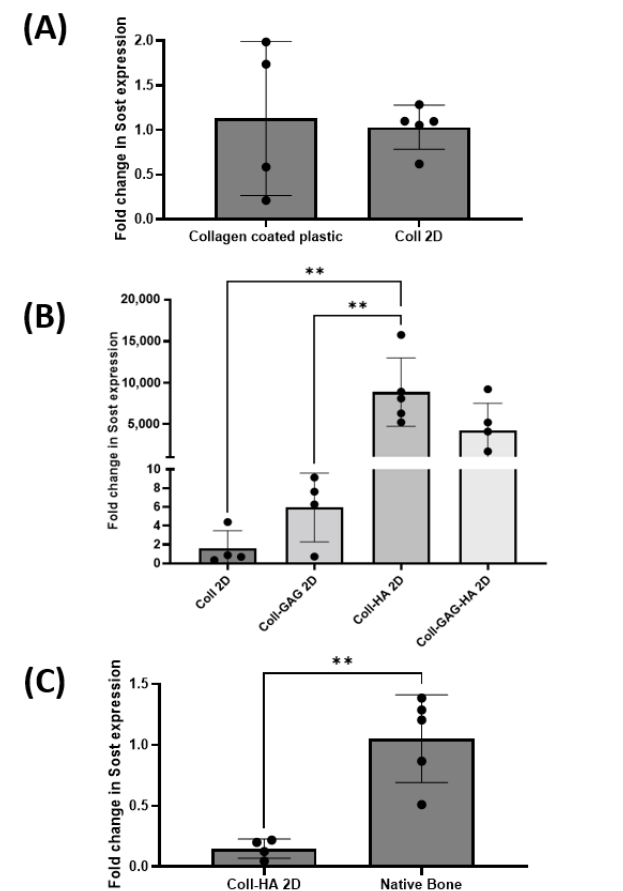
Figure 3. ( A ) MLO-Y4 Sost expression is comparable between 2D collagen coated cultures and collagen film cultures. ( B ) Films containing HA demonstrate highest levels of MLO-Y4 Sost expression. ( C ) MLO-Y4 Sost expression in Coll-HA films are significantly lower than those found in native bone. ( n = 4–5; ** p < 0.01)